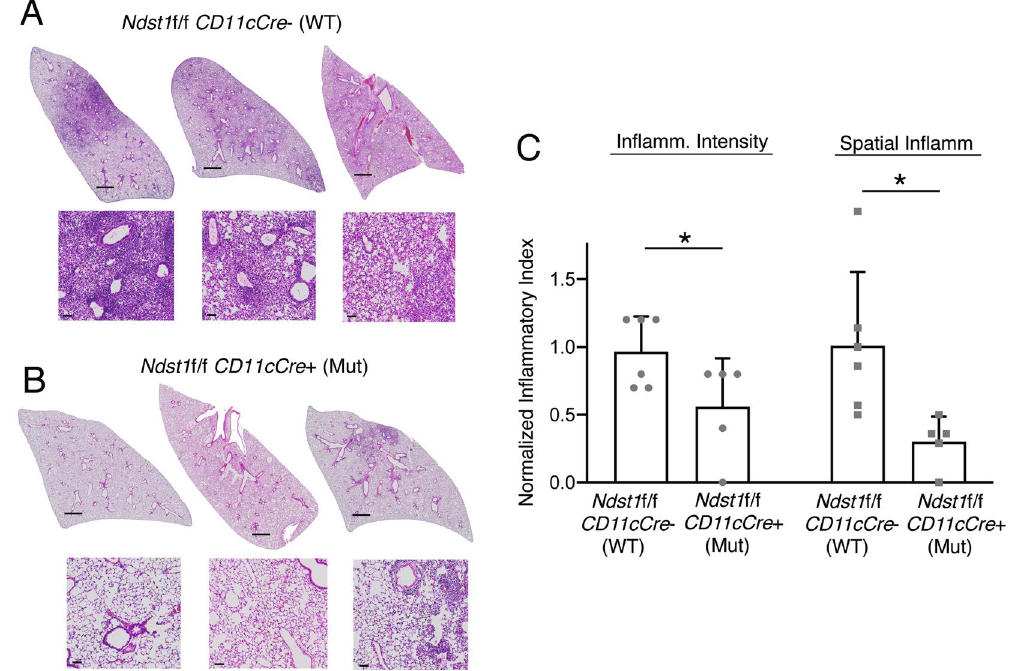
Figure 1. The magnitude of IAV lung inflammation is reduced in Ndst1f /f CD11cCre + mutant mice, with inhibition in inflammation compared to that in Ndst1f /f CD11cCre − wildtype controls at day 9 post-inoculation. Mutant and wildtype mice were inoculated with an intranasal dose of 20 PFU of PR8 IAV ( n = 5 mutant and n = 6 wildtype). At day 9 post-inoculation (p.i.) lungs were harvested, inflated, paraffin embedded, and sectioned. ( A ) Representative images of H&E-stained lung sections from IAV-infected Ndst1f /f CD11cCre − wildtype mice are shown, with representative 400X photomicrographs from inflammatory zones shown below each section (scale bar = 1 mm for low-power whole-lung images; bar = 50 μm for 400X photomicrographs). ( B ) Images of H&E-stained lung sections and representative photomicrographs from IAV-infected Ndst1f /f CD11cCre + mutant mice. ( C ) Histopathology from lung sections was analyzed by a trained pathologist blinded to genotype; and mean inflammatory index for each lung (estimated on a 0–3 scale of severity by the pathologist) was normalized from inflammatory scores of inflamed areas on lung sections. Inflammatory indices were assessed through analyses of both pathologic intensity of inflammation (left) as well as the mean spatial inflammatory involvement of lung sections (right). Spatial inflammatory involvement for any given lung section (percentage of section with any inflammation) was also initially determined through quantification by counting blinded to genotype. Mean +/− SD for the measures normalized to wildtype is shown on the graph (* P = 0.03 and * P = 0.02 for differences in means for intensity and spatial measures,